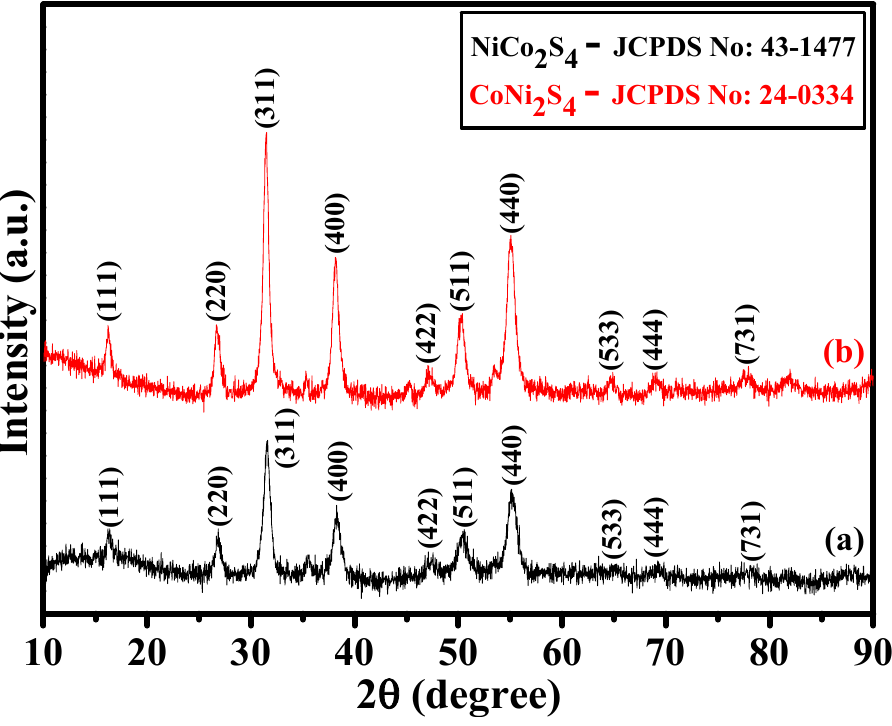
Figure 1. ( a , b ) XRD patterns of the NCS and CNS samples, respectively. The elemental oxidation states and surface chemical composition of as-synthesized NCS and CNS materials were evaluated by X-ray photoelectron spectroscopy (XPS). The survey scan spectrum of NCS and CNS samples (Figure 2a) indicates the presence of